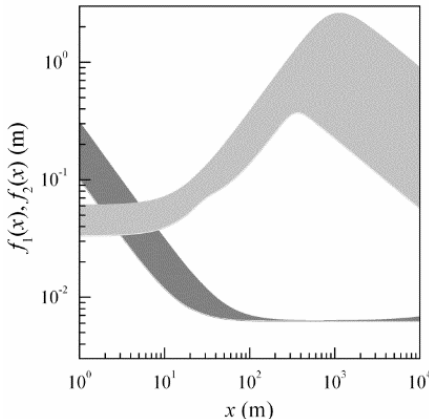
 . The grey- Figure 4. The nomogram for choosing the spacing between optical axes of laser beams tr colored region shows the variability range of the function   xf , and the region in light grey depicts 1 the variability range of the function   xf . 2 Figure 4. The nomogram for choosing the spacing between optical axes of laser beams ρ tr . The Figure 4. The nomogram for choosing the spacing between optical axes of laser beams tr  . The grey- grey-colored region shows the variability range of the function f 1 p x q , and the region in light grey colored region shows the variability range of the function   xf 1 , and the region in light grey depicts depicts the variability range of the function f 2 p x q . the variability range of the function   xf 2 .  of radiative sources that produce interference pattern must be Considering that the spacing tr and smaller than the values of the function , data larger than the values of the function   xf 1  of Figure 4 for pathlengths x from 20 m to 10 km can be used to estimate the admissible values of tr in the range from 1 cm to 5 cm. It is just these spacings of radiative sources tr  that were used below to estimate ILS operability. 5 cm. Panels in 5 cm. Panels in Figure 5a–e represent the color polar contour plots (100 shades of two colors).